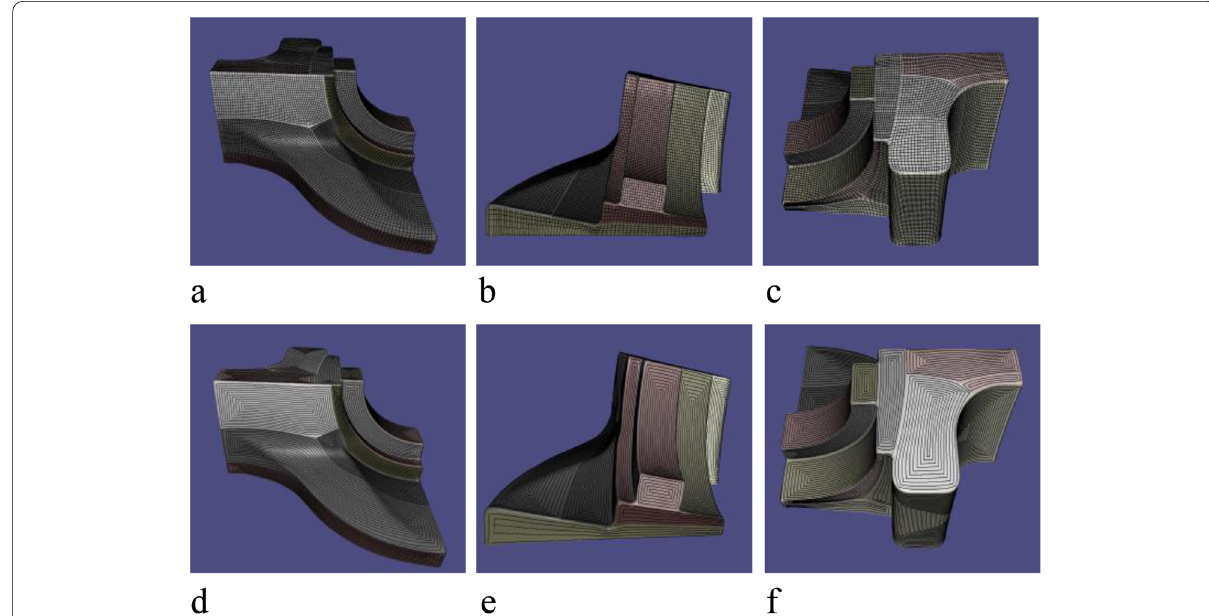
Fig. 19 Tool path of Fandisk model: a ‑ c are model’s grid; d ‑ f are corresponding tool path